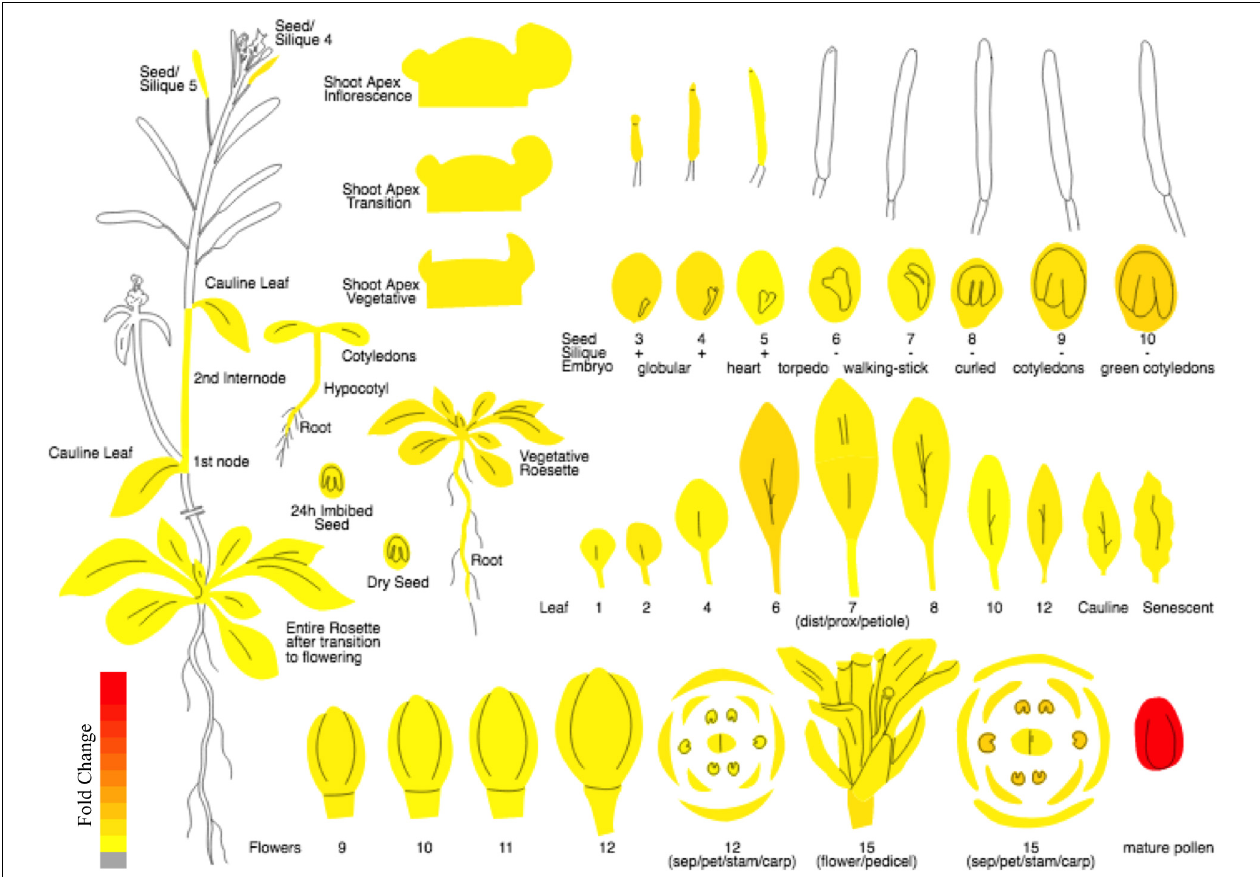
FIGURE 2 | The expression atlas of 3p.AtFBP113 . The pictograph demonstrates the expression pattern of 3p.AtFBP113 across the entire plant. The 3p.AtFBP113 exhibits high and preferential expression in mature pollen. The color legend shows the expression levels in the form of fold change, where red color shows maximum and yellow color represents minimum